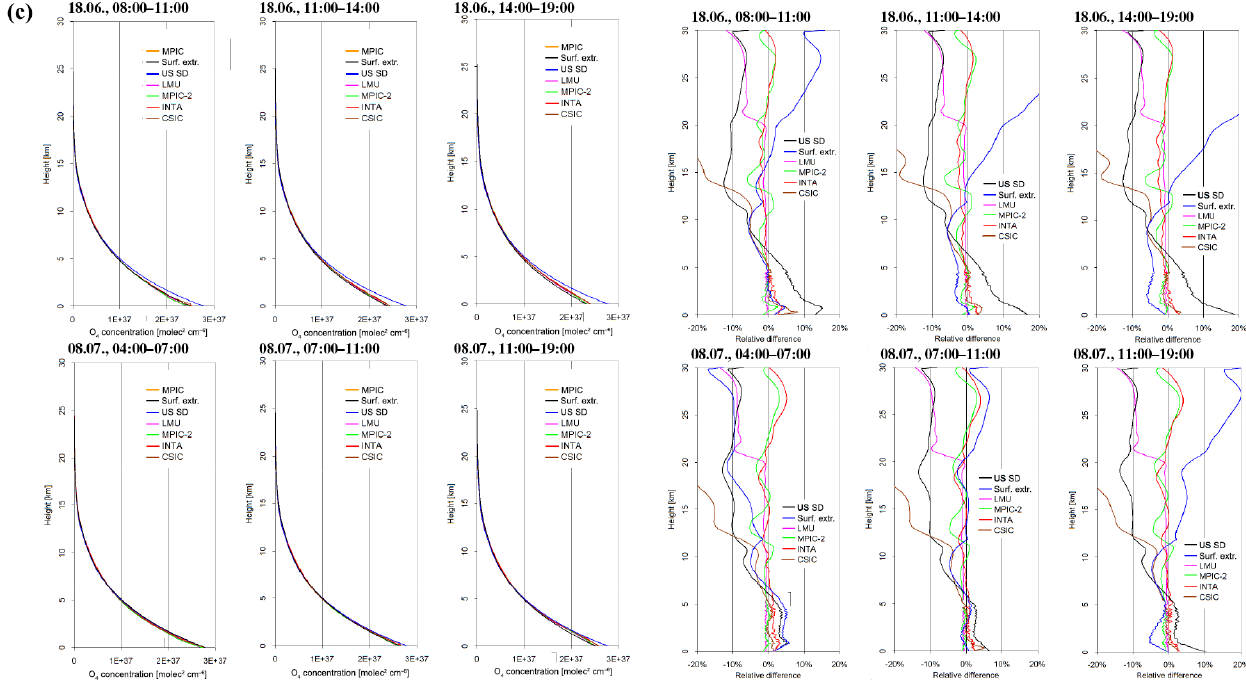
Figure A5. (a) Left: Comparison of temperature profiles extracted by the different groups (also shown are the profiles from the US standard atmosphere and the profiles extrapolated from the surface measurements). Right: Differences in these profiles compared to the MPIC standard extraction. (b) Left: Comparison of pressure profiles extracted by the different groups (also shown are the profiles from the US standard atmosphere and the profiles extrapolated from the surface measurements). Right: Differences in these profiles compared to the MPIC standard extraction. (c) Left: Comparison of O 4 concentration profiles extracted by the different groups (also shown are the profiles from the US standard atmosphere and the profiles extrapolated from the surface measurements). Right: Differences in these profiles compared to the MPIC standard